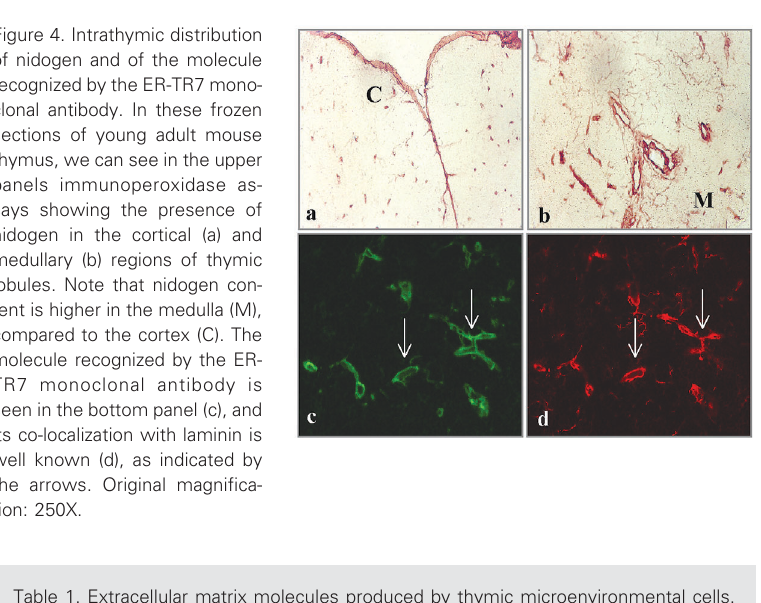
Table 1. Extracellular matrix molecules produced by thymic microenvironmental cells. Molecule